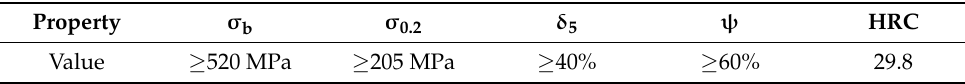
Table 2. Mechanical property of AISI 304 stainless